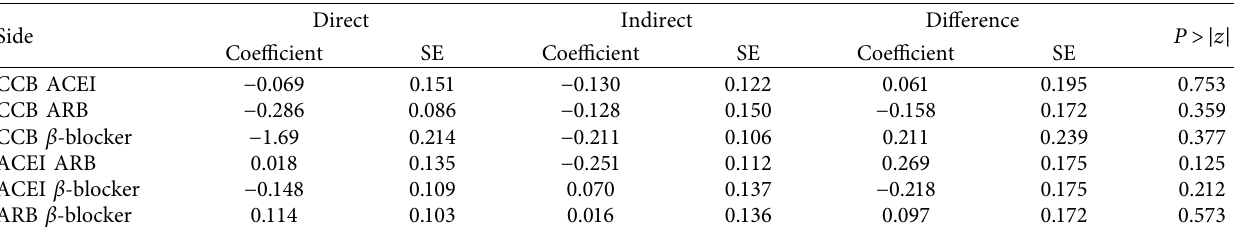
Table 3: Inconsistency test between direct and indirect treatment comparisons in mixed treatment comparison in